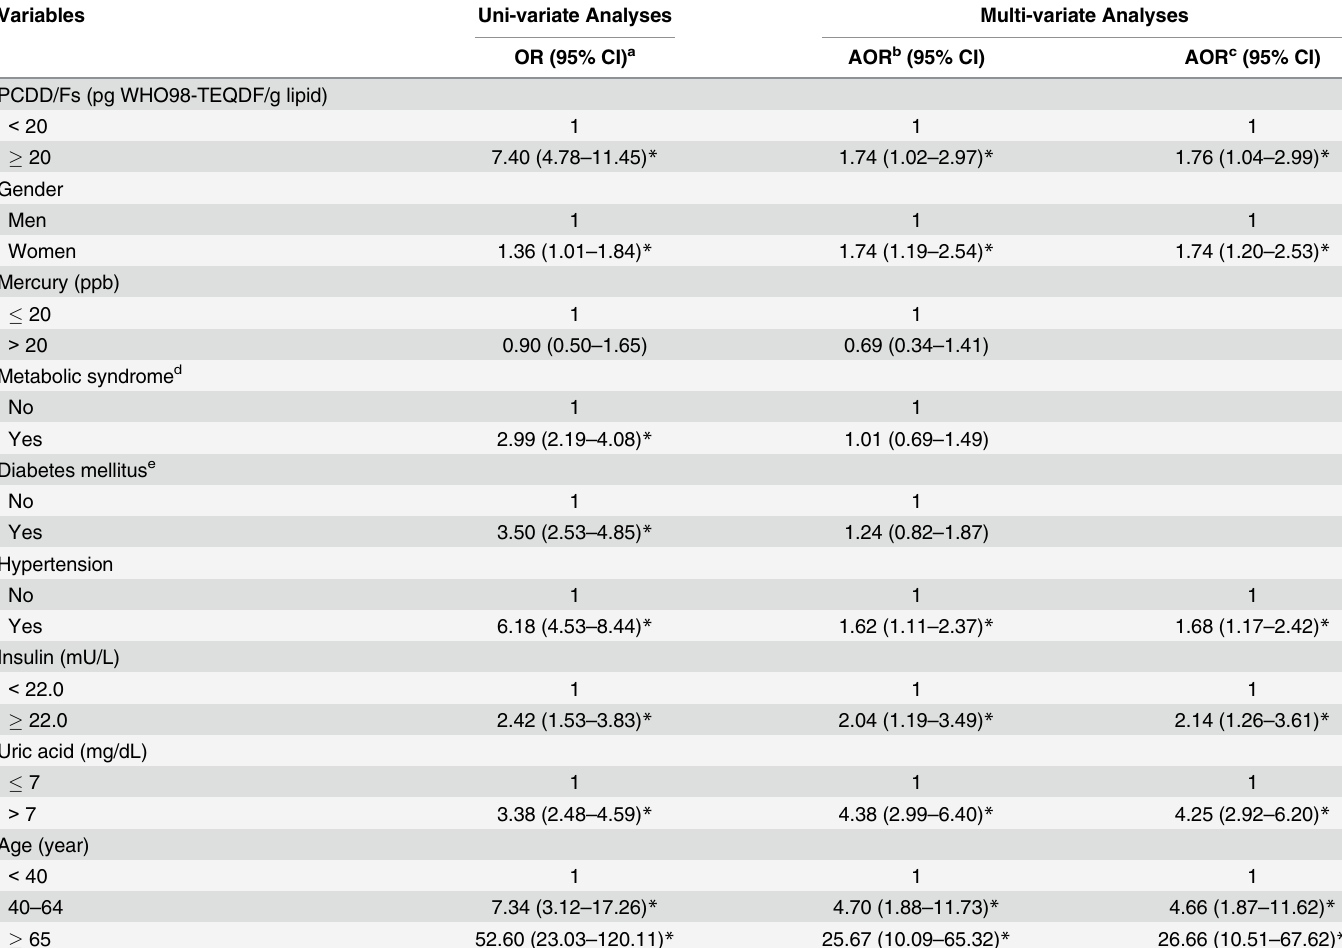
Table 4. Risk factors and associated odds ratios for chronic kidney disease among the